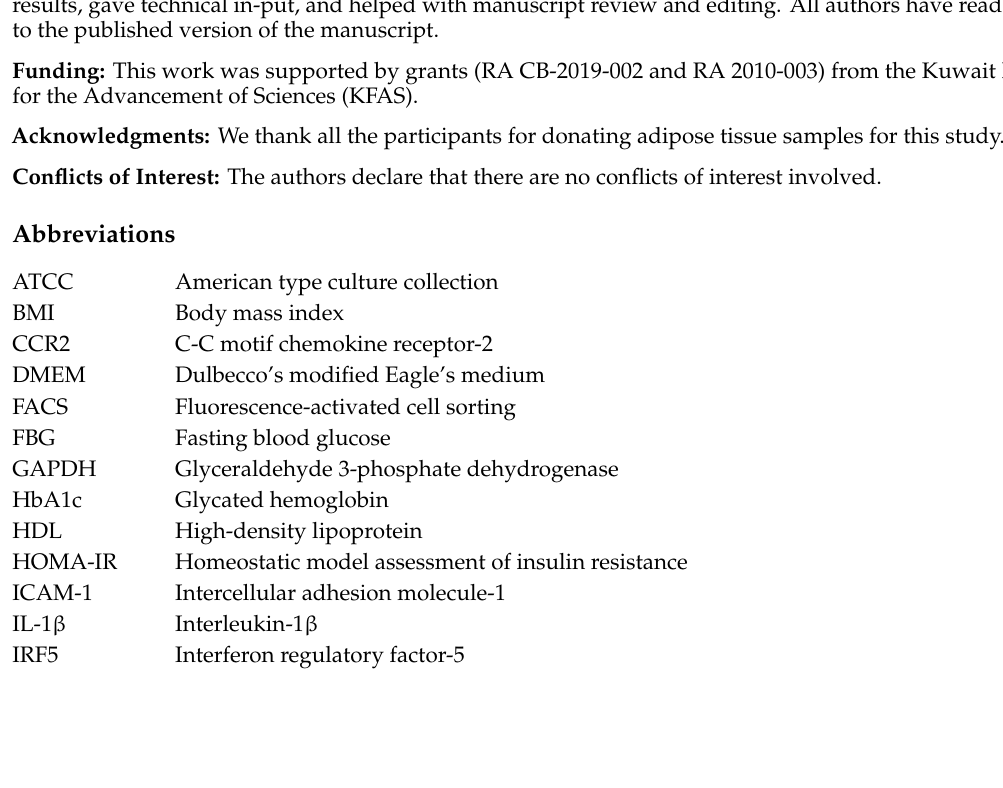
Table S1: Demographic and study population characteristics, Table S2: Clinical characteristics of the study